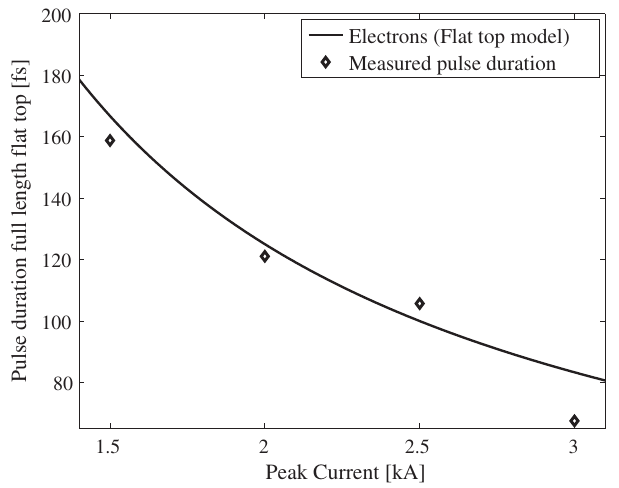
FIG. 8. (Diamonds) Measured x-ray pulse duration vs different peak currents, duration expressed as flattop full length. (Solid) Electrons bunch length for a 250 pC flattop profile as a function of the peak current.